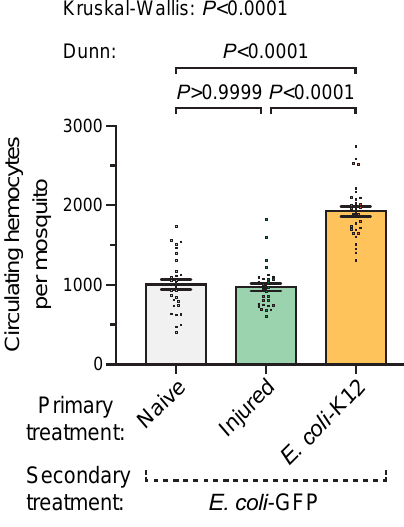
Figure 3. Number of circulating hemocytes after secondary treatment. Five days after the primary treatment of naïve, injury, or infection with E. coli -K12, all the mosquitoes were infected with E. coli -GFP and the number of circulating hemocytes was counted 1 day later. Column heights mark the mean and whiskers denote the SEM. Circles mark the number of hemocytes in individual mosquitoes.